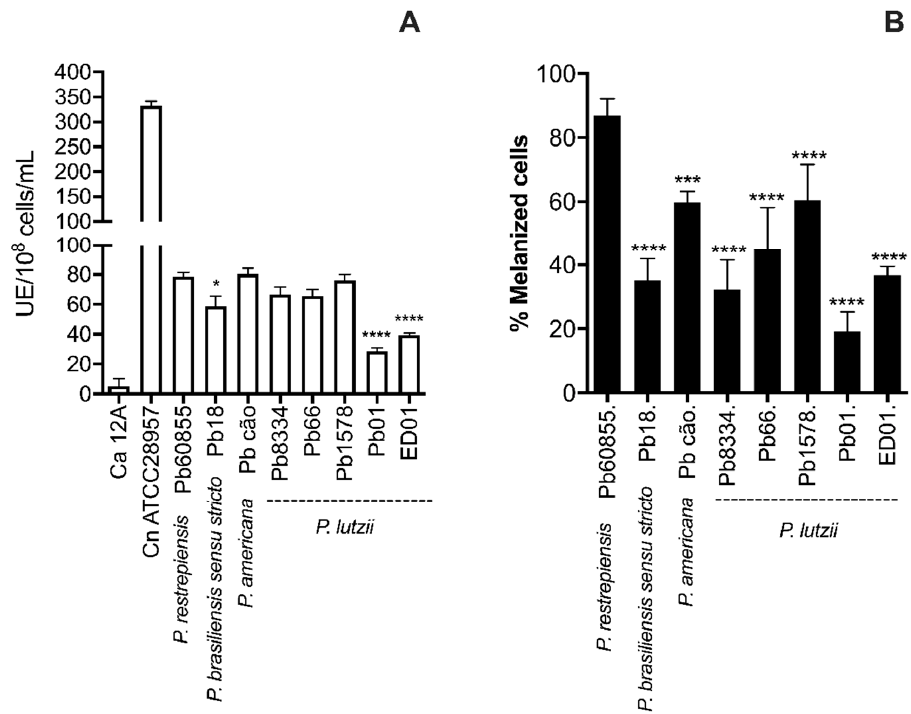
Figure 2. Pigmentation and laccase activity of Paracoccidioides isolates. Laccase activity was determined by colorimetric analysis ( A ). Percentages of melanized yeasts in medium with 1 mM L-DOPA, 37 ◦ C, after 15 days of incubation ( B ) as determined by optical microscope visualization and counting. C. albicans 12A (Ca 12A) and C. neoformans (Cn ATCC28957) were used as negative and positive controls, respectively. The statistical representative di ff erences were analyzed by one-way ANOVA followed by Tukey’s post-test, where * p < 0.05, *** p < 0.001, and **** p < 0.0001 in comparison between the Pb60855